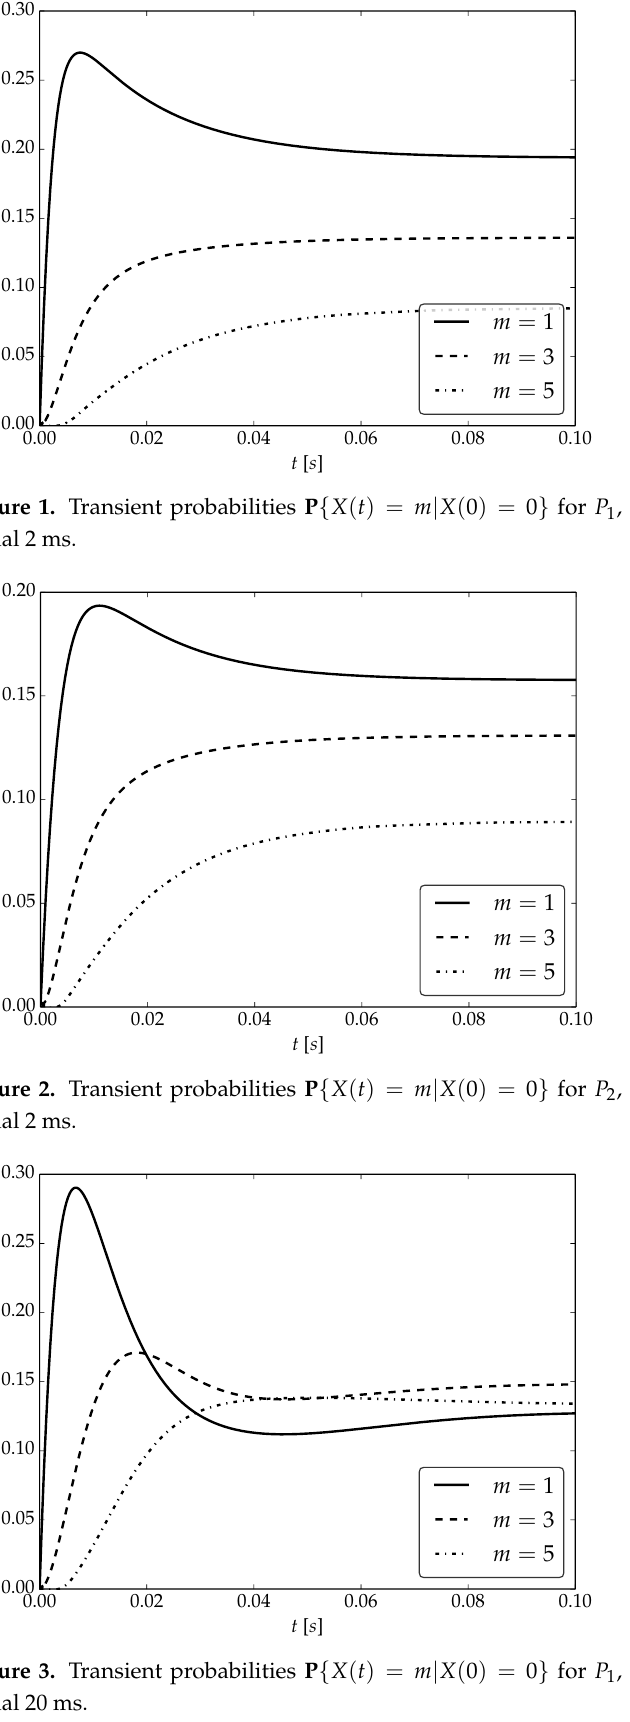
Figure 3. Transient probabilities P equal 20